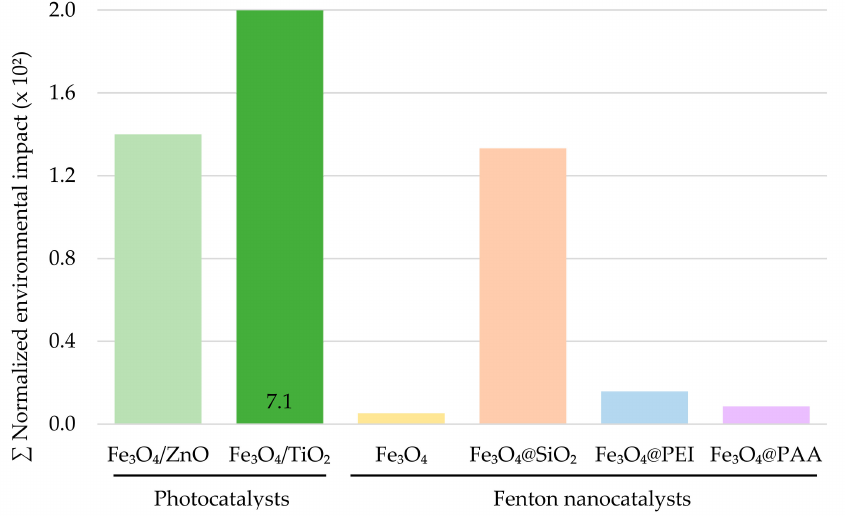
Figure 2. Environmental impacts associated with the synthesis routes of magnetic NPs.